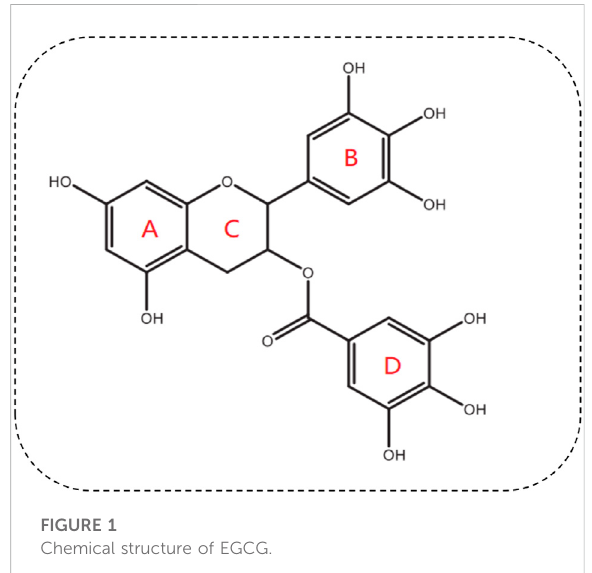
FIGURE 1 Chemical structure of